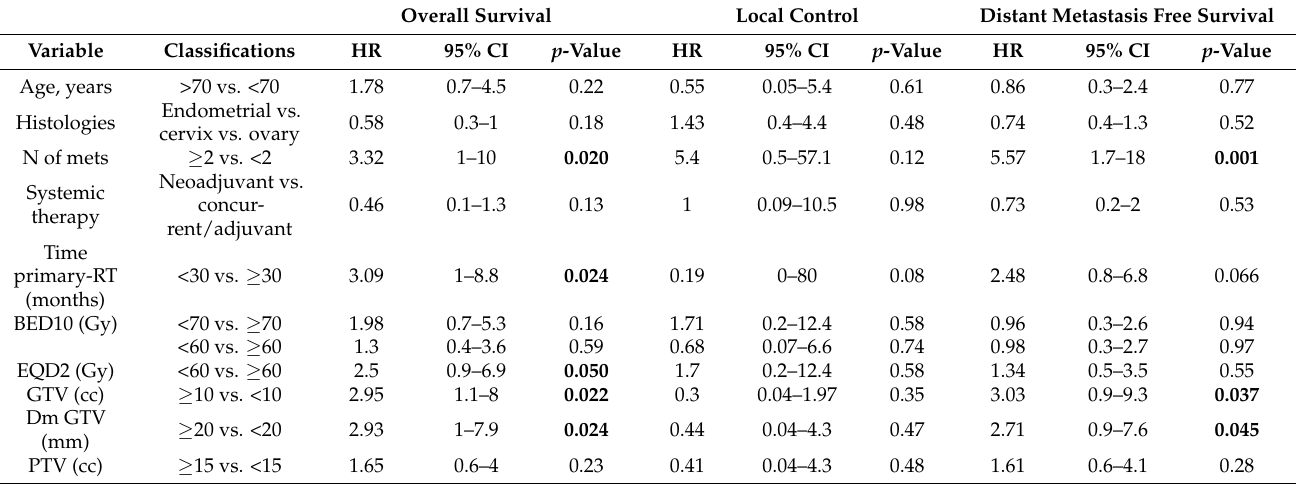
Table 3. Treatment outcomes.